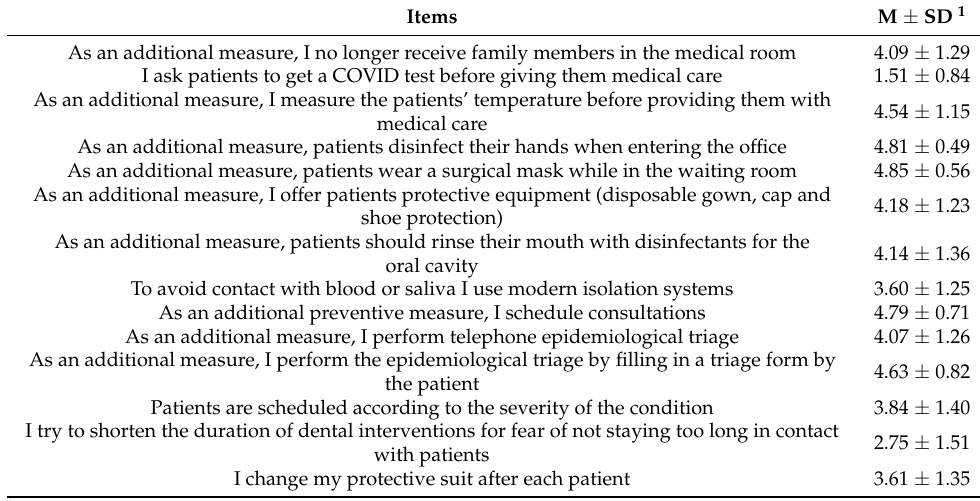
Table 3. Supplementary measures and new practices adopted to diminish the risk of